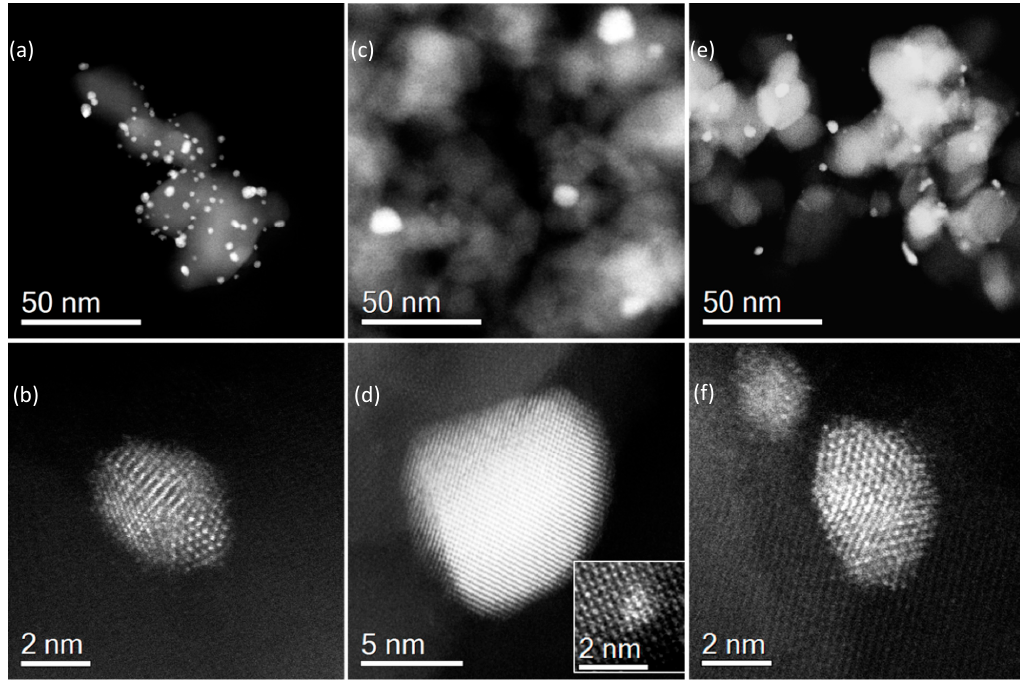
Figure 4. Representative HAADF-STEM images of a 1% AuPd/TiO 2 catalyst prepared by ( a , b ) sol- immobilization; ( c , d ) conventional impregnation; ( e , f ) modified impregnation.